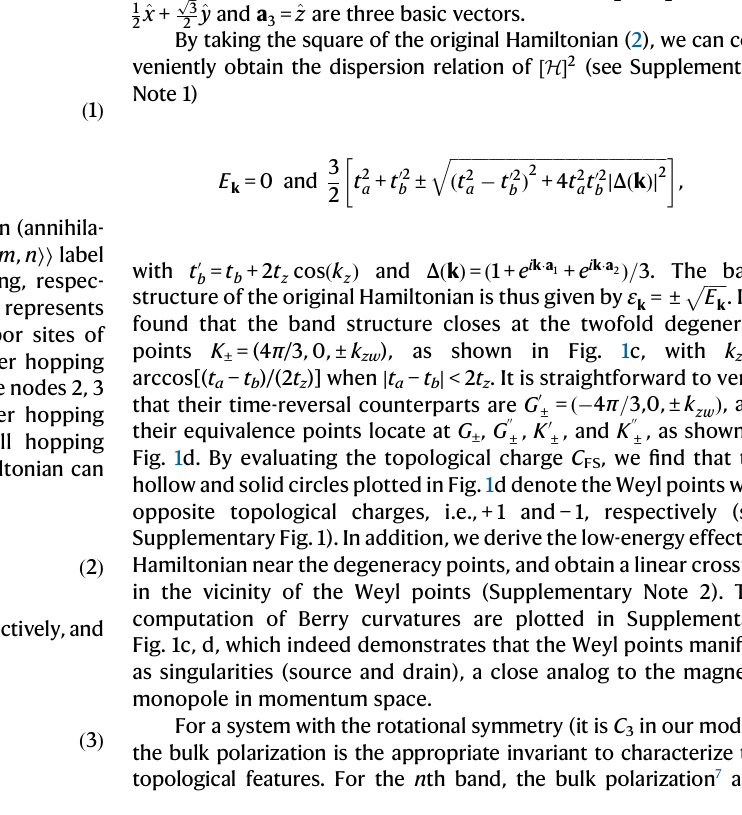
parents. c The bulk dispersion along the k z direction with ( k x , k y )=(4 π /3,0). The dashed blue line indicates the position of the degenerate points. d The fi rst Bril- louin zone and the distribution of the Weyl points. The hallow and solid circles represent the Weyl point with the charge±1. e Bulkpolarization p 1 asa function of k z . For TB calculations in c and e , we set t a =0.5, t b =1, and t z